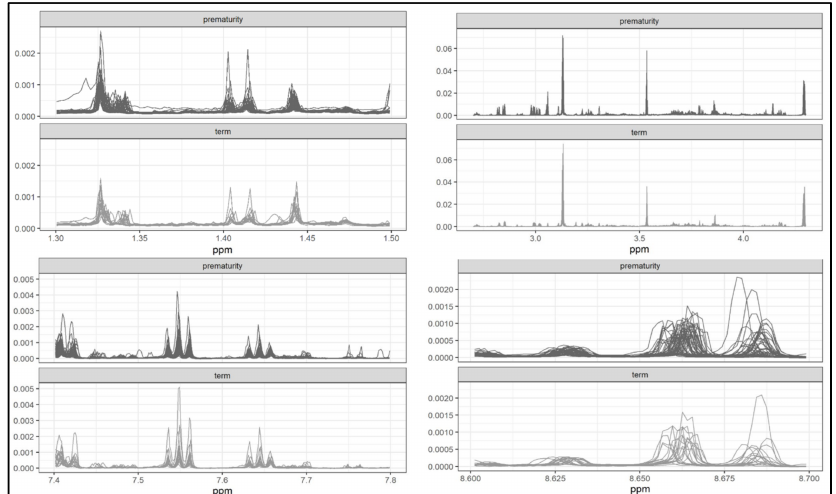
Figure 7. Spectra of the most important signals in the two